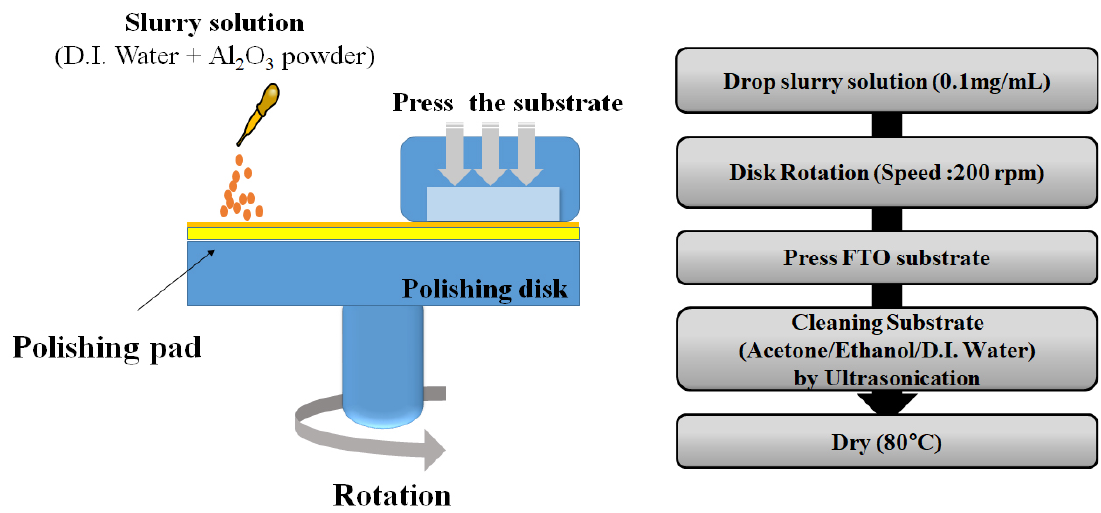
Figure 1. Schematics diagram and surface treatment process chart of the chemical mechanical polishing (CMP) process.